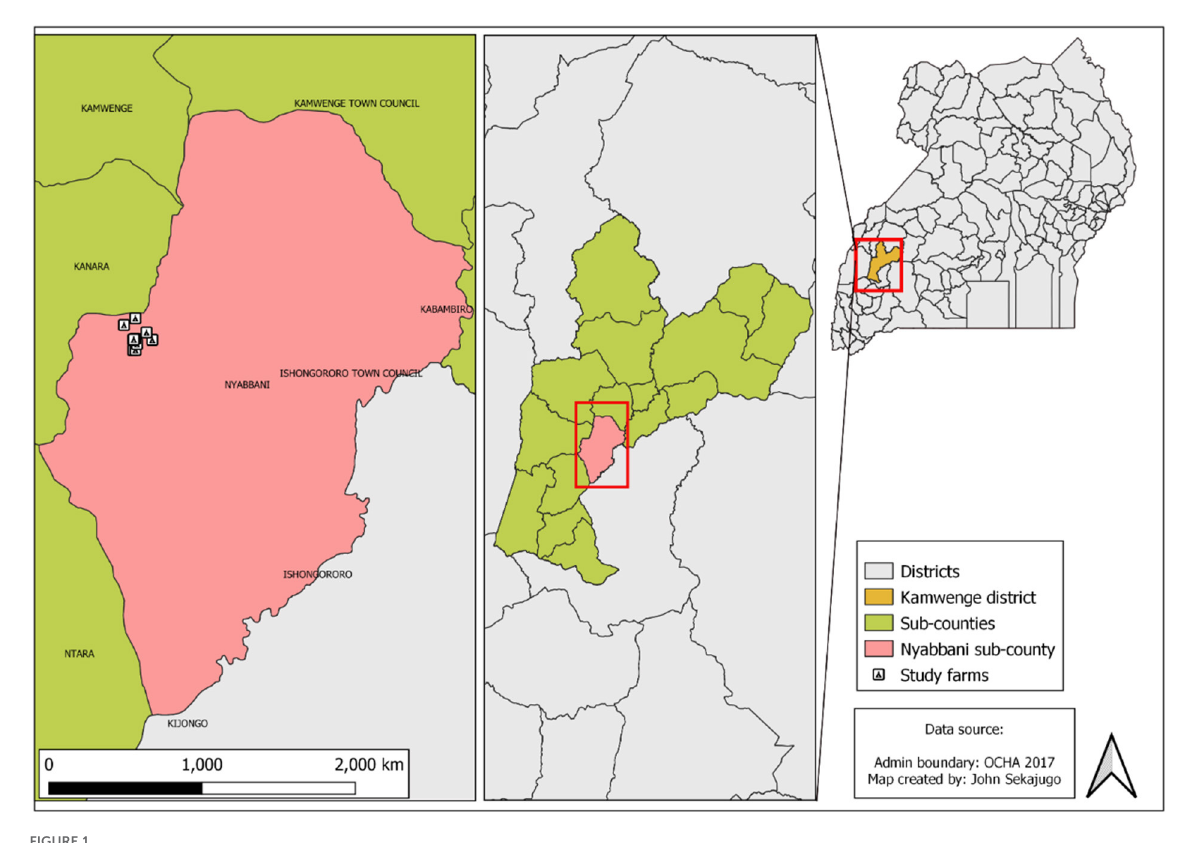
FIGURE1 Location of the study farms in Kamwenge district, Uganda. Source Ekyaligonza et al. (2022).